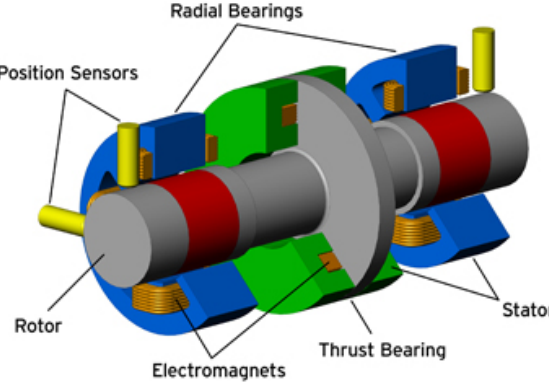
Figure 2. Assembly of an AMB